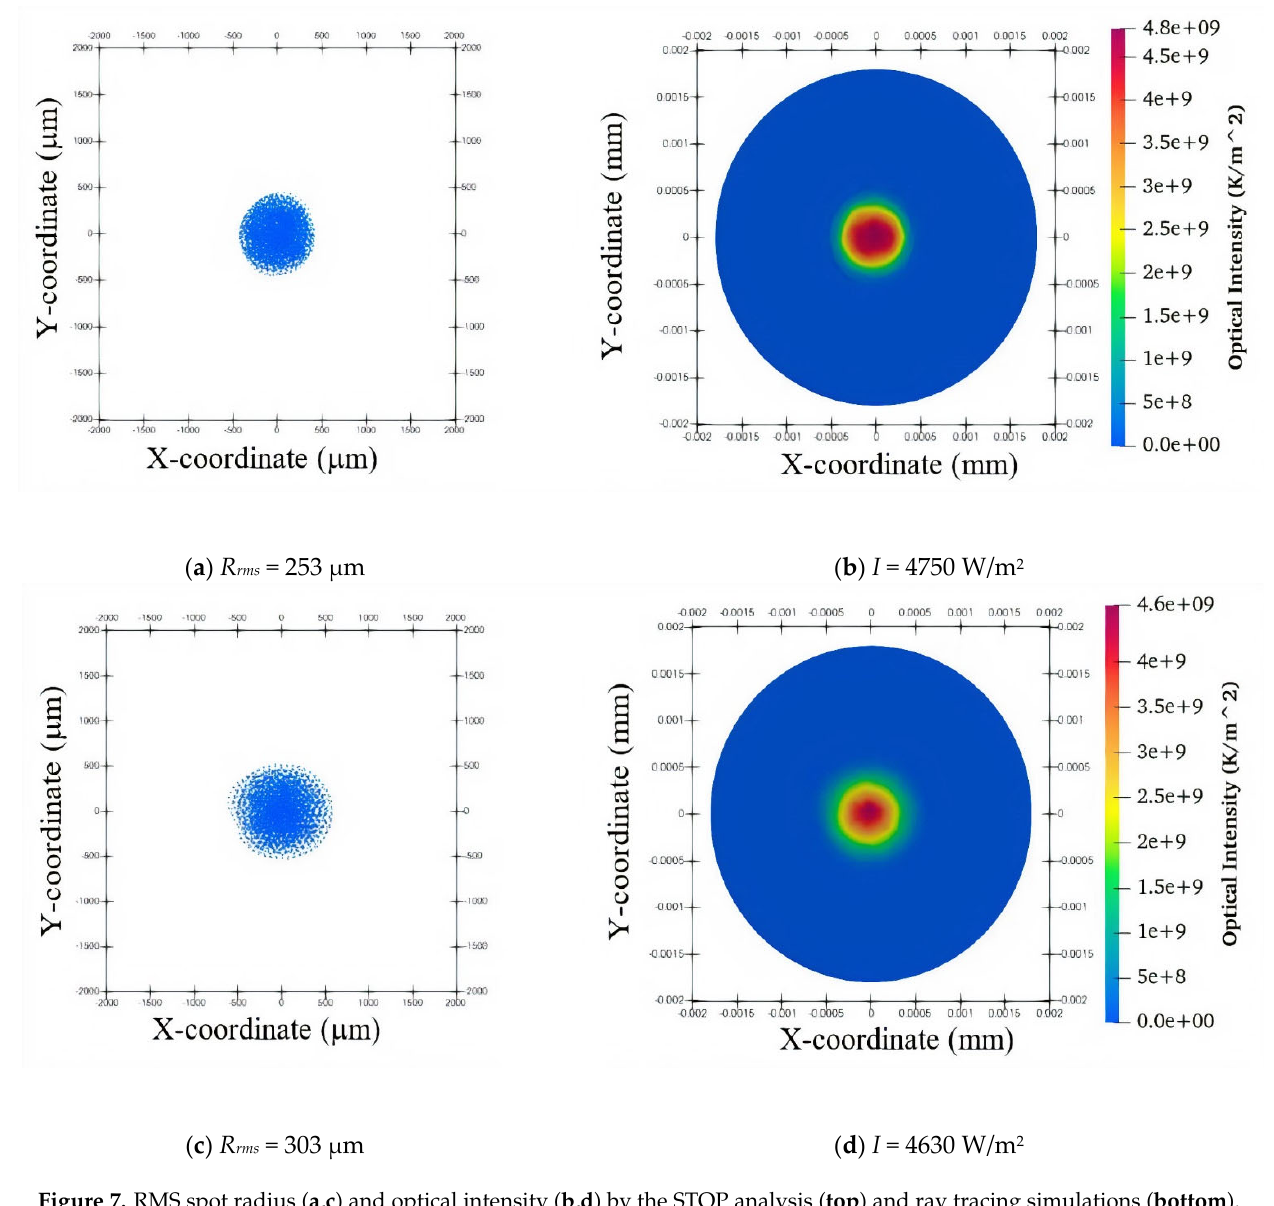
Figure 7. RMS spot radius ( a , c ) and optical intensity ( b , d ) by the STOP analysis ( top ) and ray tracing simulations ( bottom ).